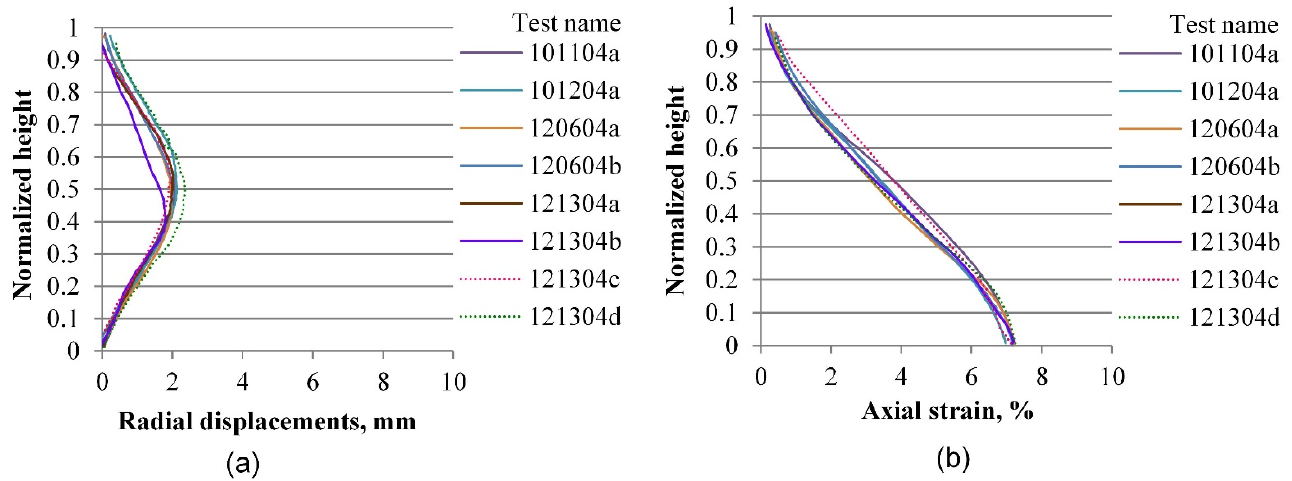
Figure 24. Vertical profiles of averaged displacements at 7.0% of the axial strain of sand specimens